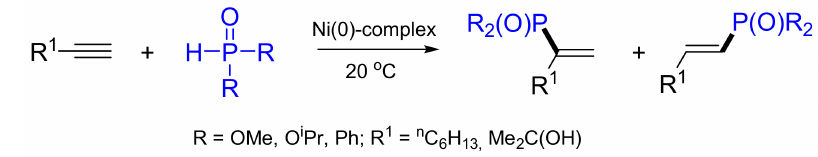
Figure 16. Nickel-catalyzed addition of R 2 P(O)H to alkynes.